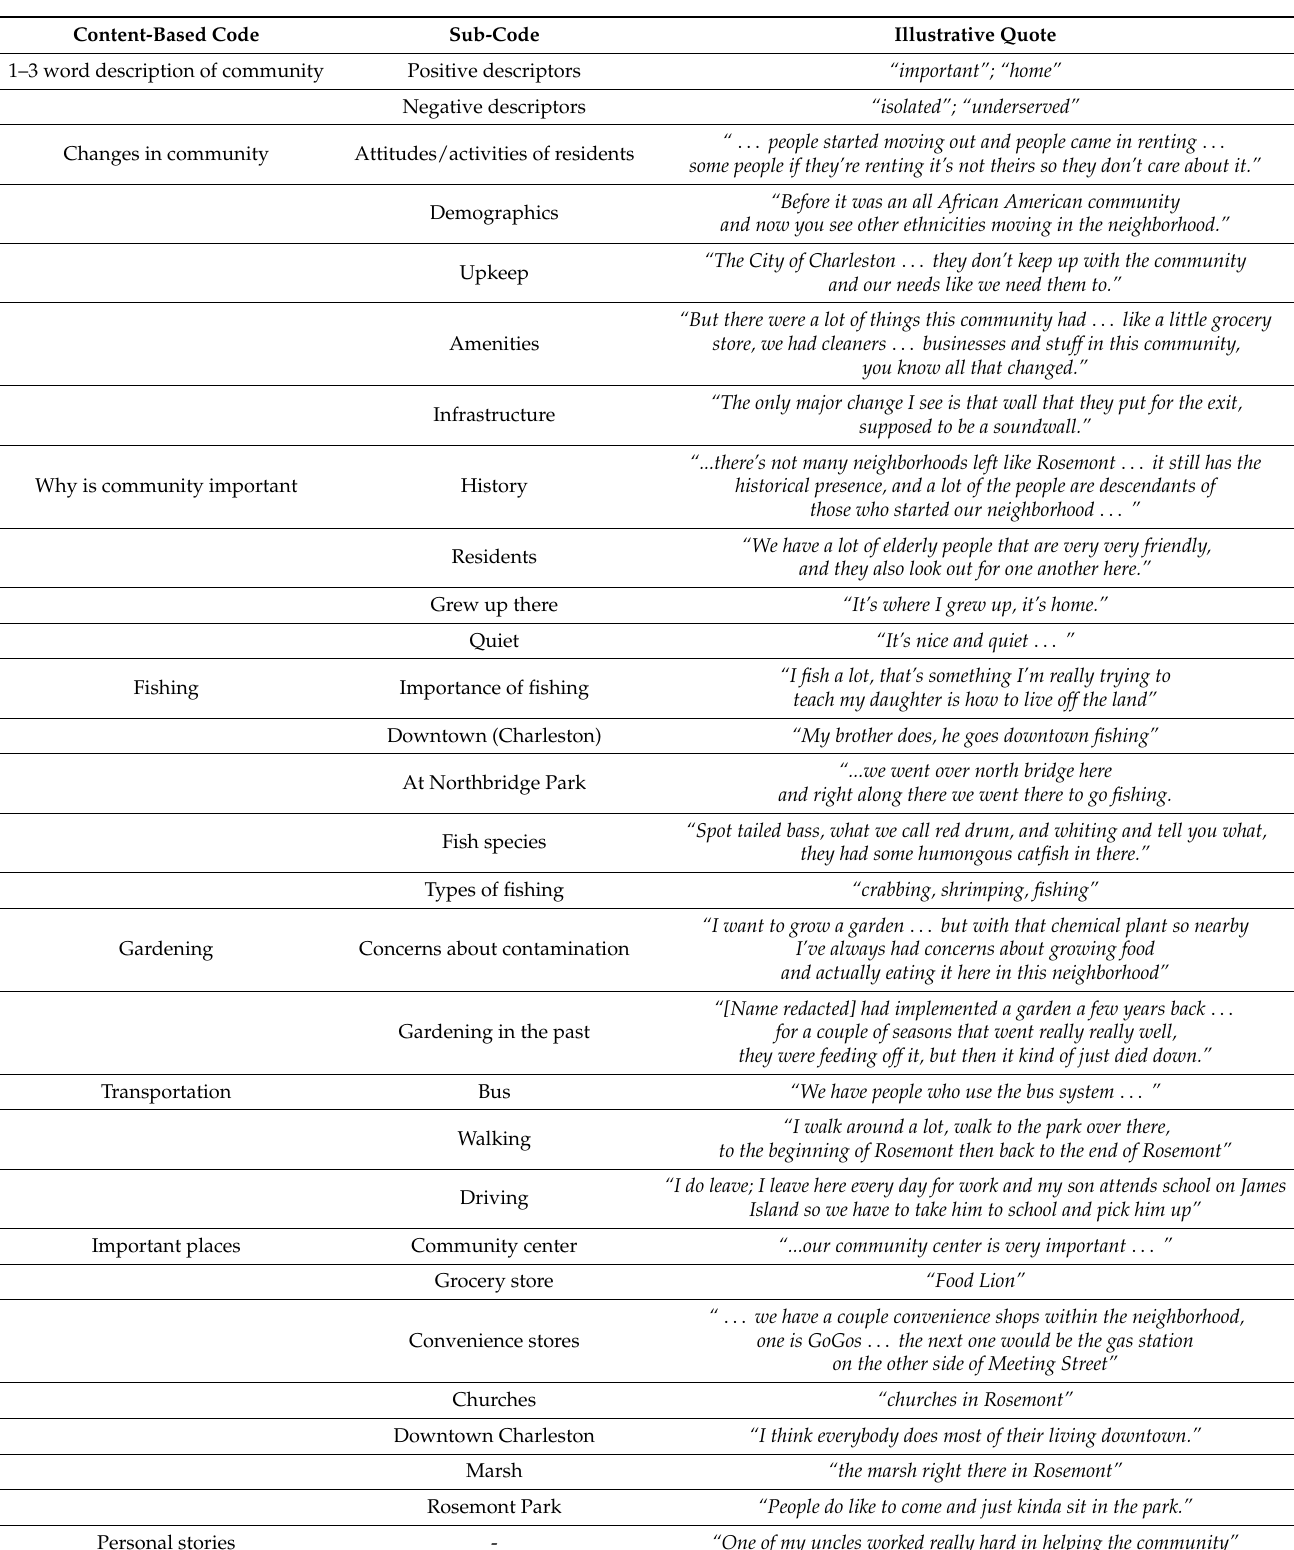
Table 3. Codes and examples used to categorize the content of interview responses and data gathered from community meetings and other sources in NVivo. We use italics throughout the paper to clearly identify quotes from study